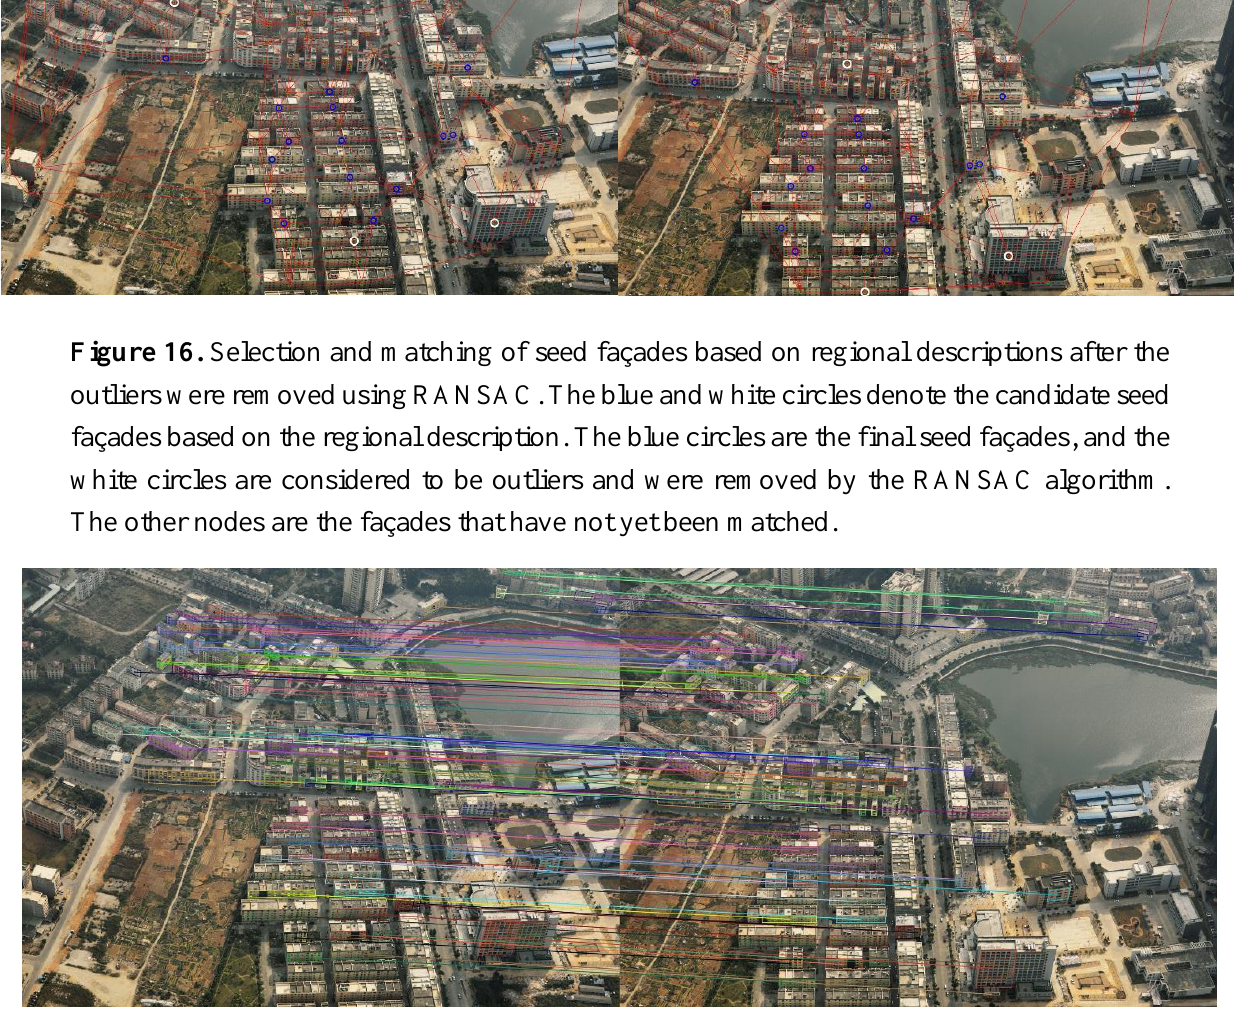
Figure 17. Results of the façade regional feature matching based on mutual geometric relationships with the seed façades. The correspondences are linked with